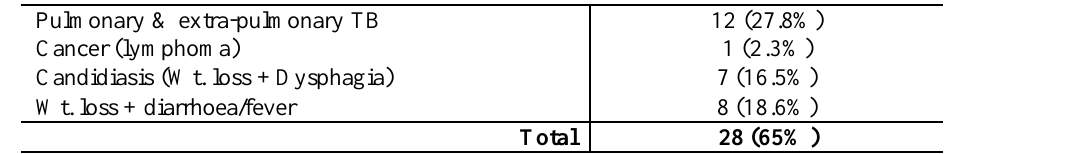
Table VII : Clinical AIDS (according to Expanded ‘WHO’ Case Definition for AIDS Surveillance): (N=43) Pulmonary & extra-pulmonary TB Cancer